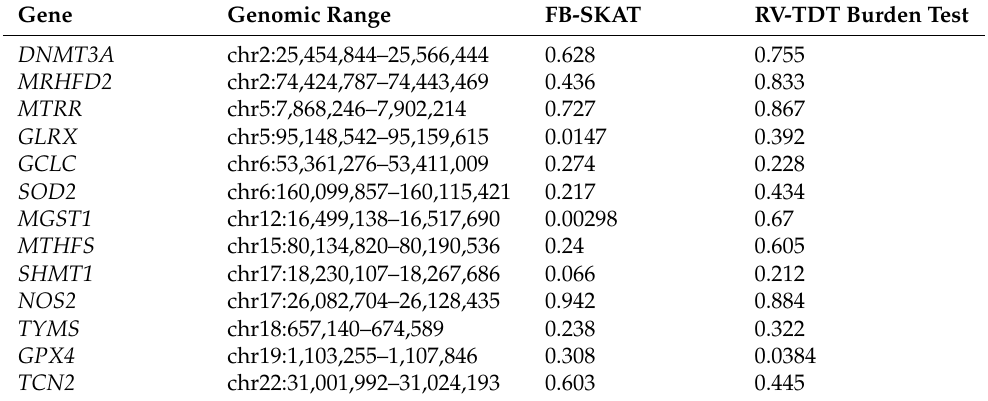
Table 5. Region-based analysis for rare